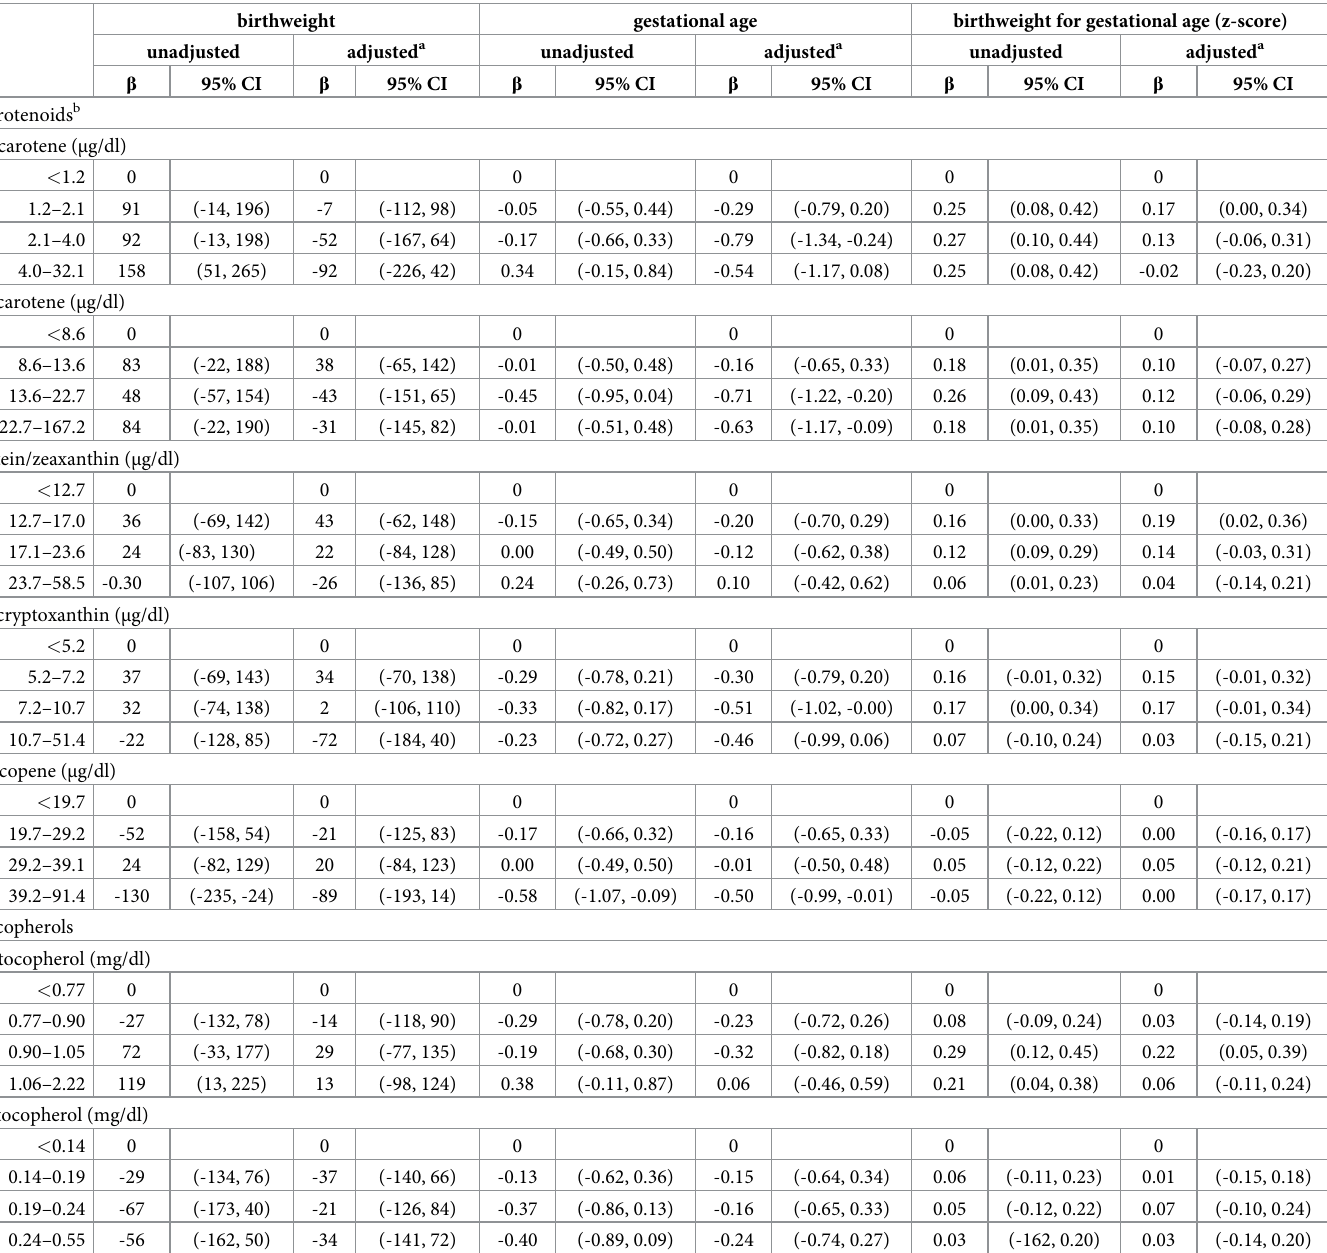
Table 3. Relationship between serum antioxidant status, as quartiles, and subsequent birth